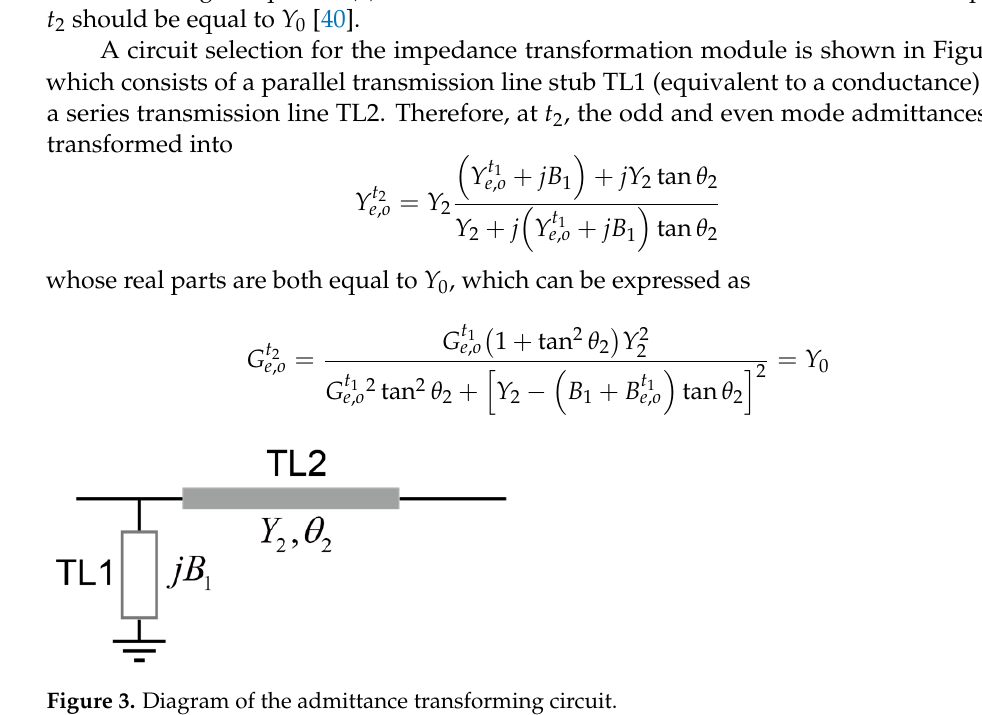
4 of 15 Figure 2. Equivalent circuit diagram of the symmetrical three-port network at reference plane t 1 .